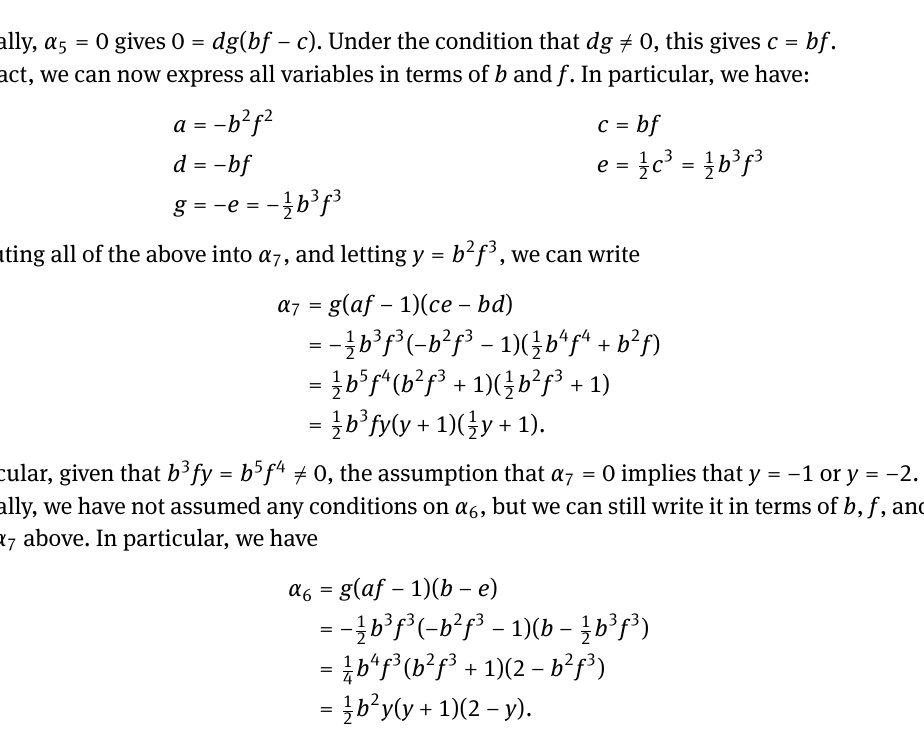
Figure 3: Digraph for the second exceptional pattern found by Algorithm